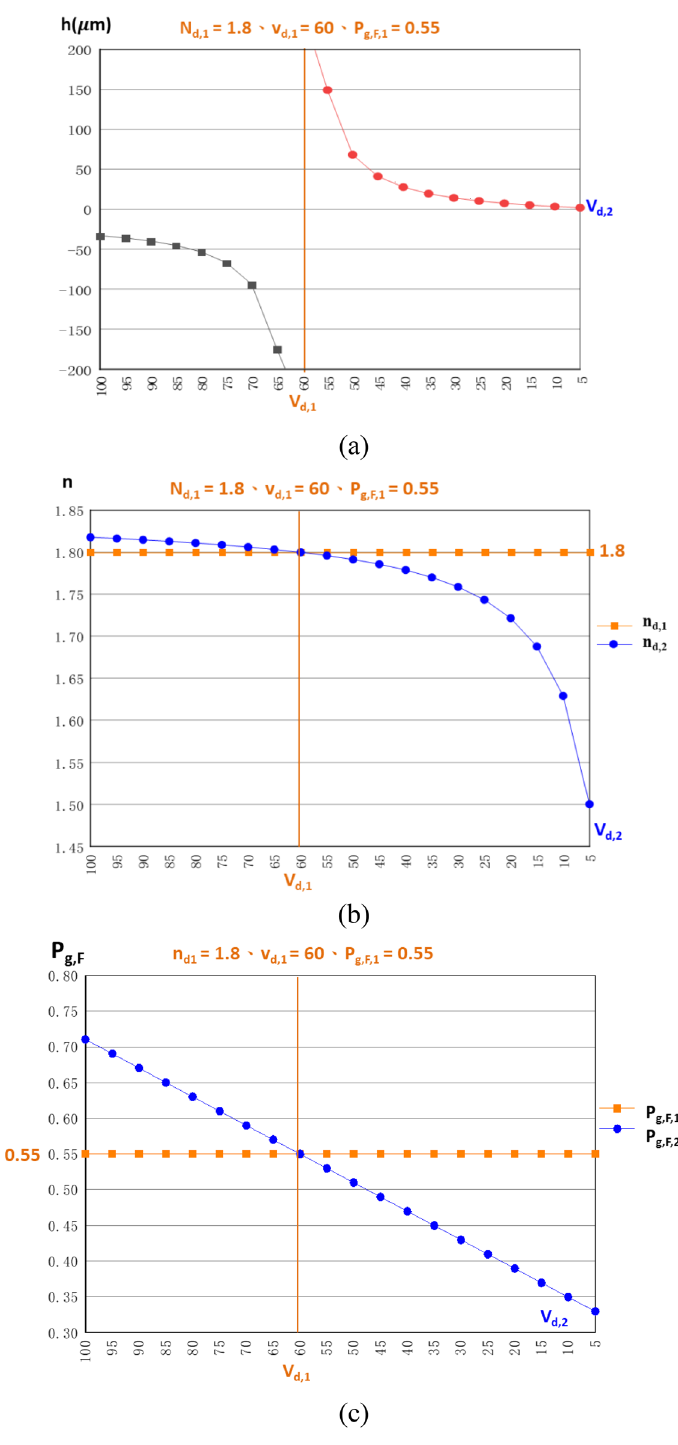
Figure 7. Optical behavior of convergence and divergence in TM-DFL. ( a ) FZ height h is calculated and plotted as a function of v d.2 , where TM-DFL becomes optical transparent when v d,2 = v d,1 = 60. ( b , c ) TM-DFL is equipped with the focusing power when v d,2 < v d,1 , h > 0, n d,2 < n d,1 , and P g,F,2 < P g,F,1 , while TM-DFL is equipped with the divergent power when v d,2 > v d,1 , h < 0, n d,2 > n d,1 , and P g,F,2 > P g,F,1